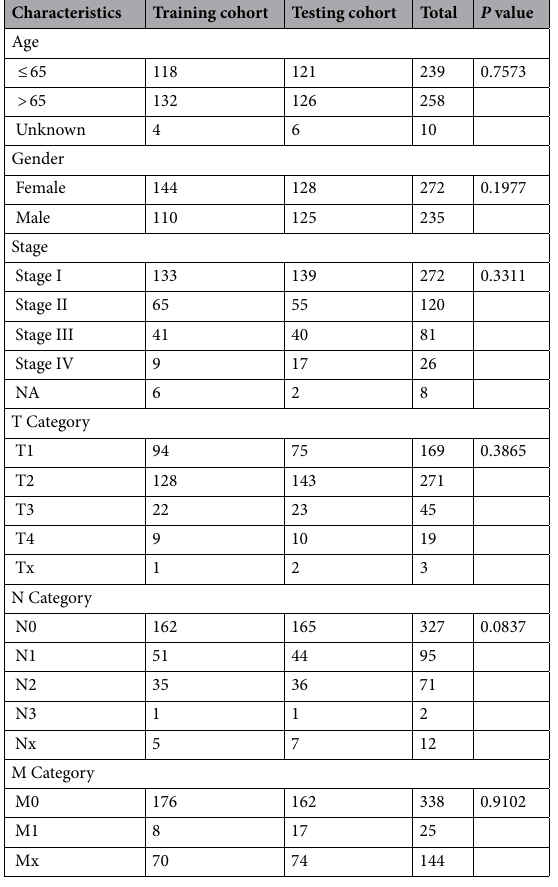
Table 1. Baseline characteristics of the LUAD patients. LUAD: lung adenocarcinoma; NA: not available;